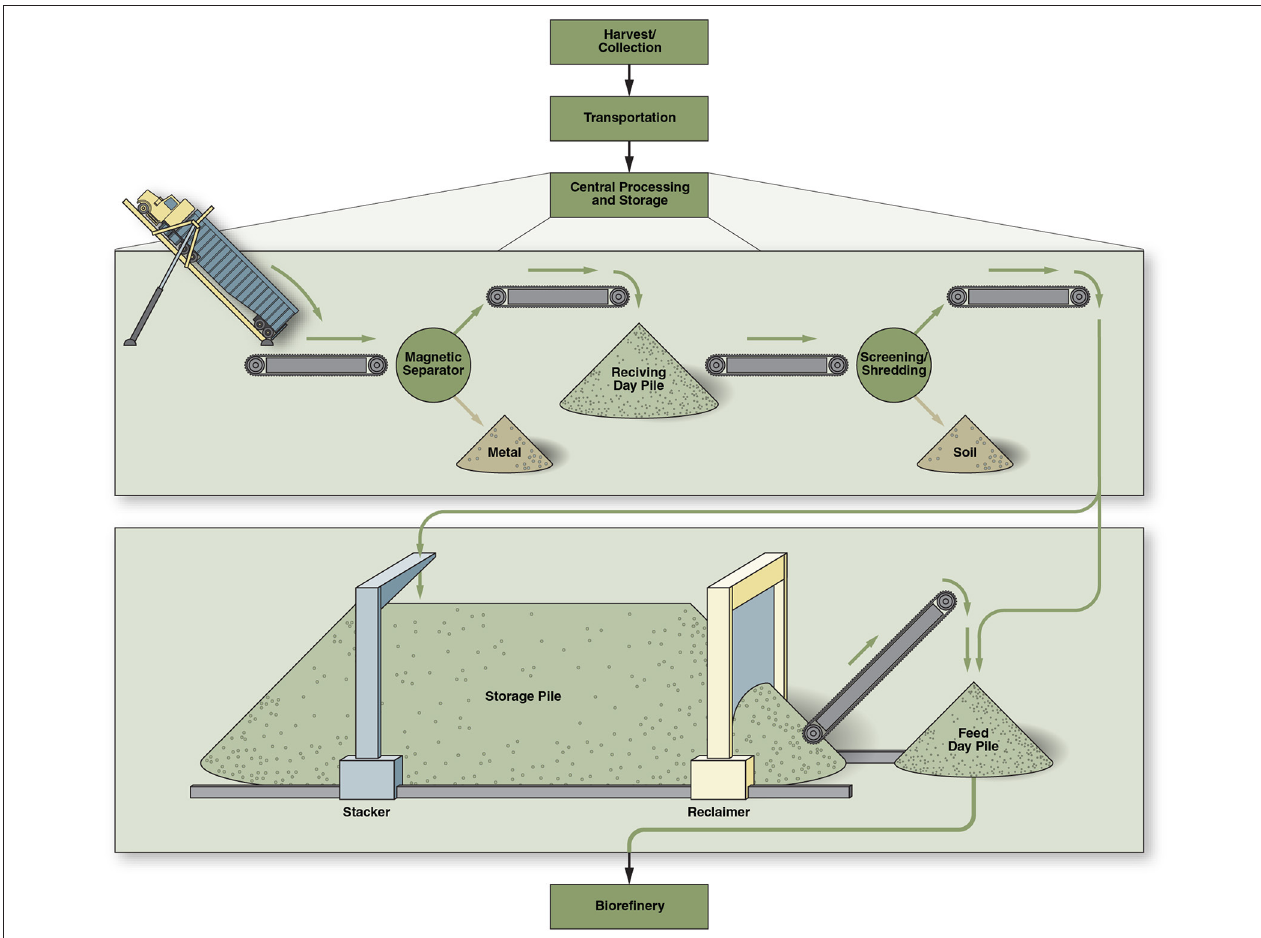
FIGURE 1 | Centralized processing and storage operations in the chopped feedstock logistics supply